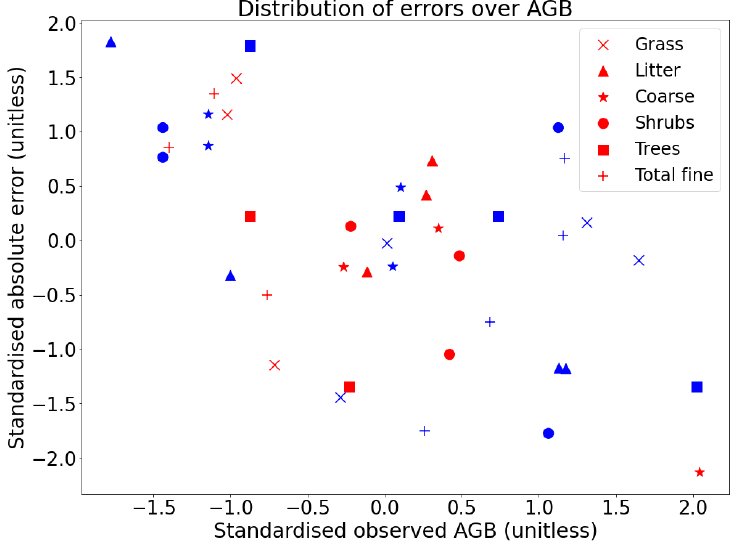
Figure 10. Standardised error on observed values across all fuel classes and regions. A red marker indicates data from Tsodilo and blue from